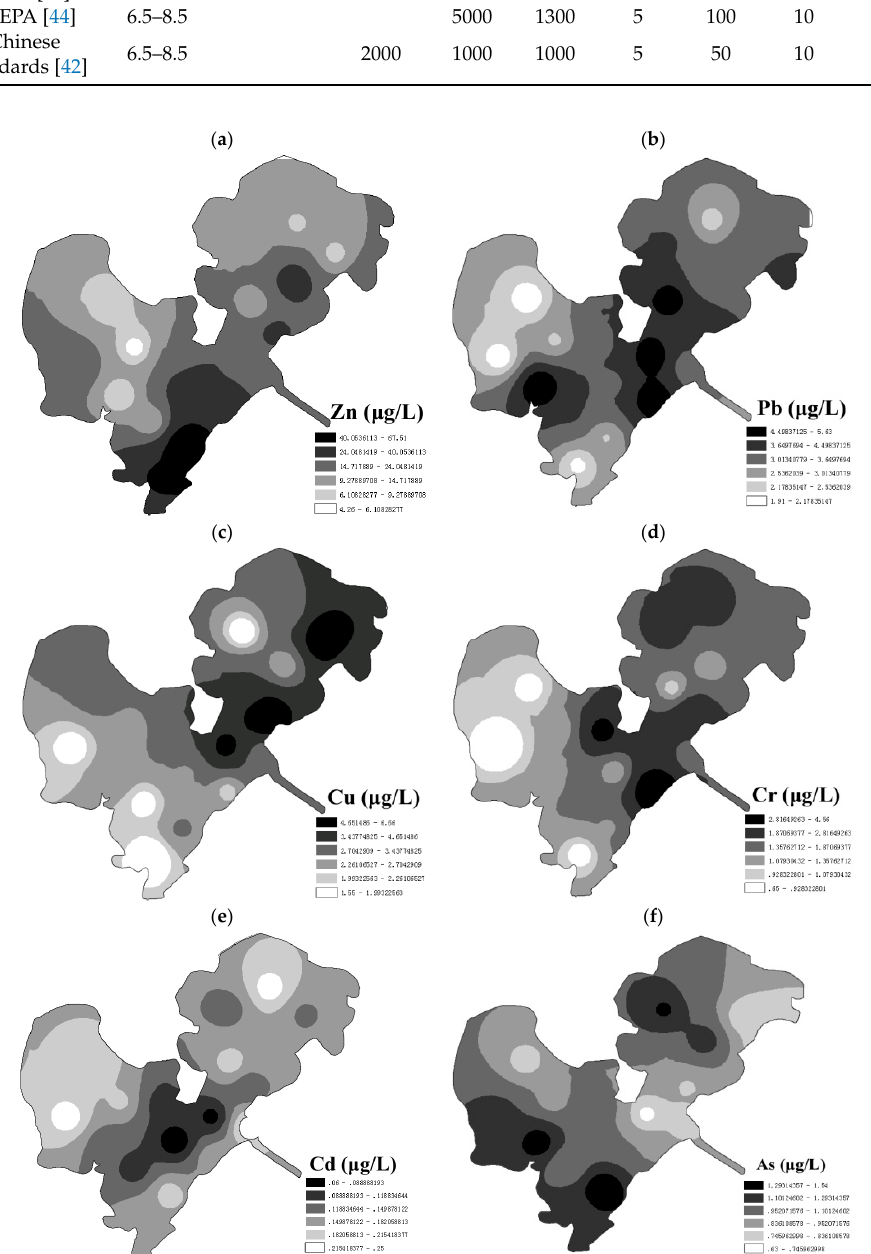
Figure 2. Spatial distribution of Zn ( a ), Pb ( b ), Cu ( c ), Cr ( d ), Cd ( e ) and As ( f ) in surface water from Honghu Lake. Honghu